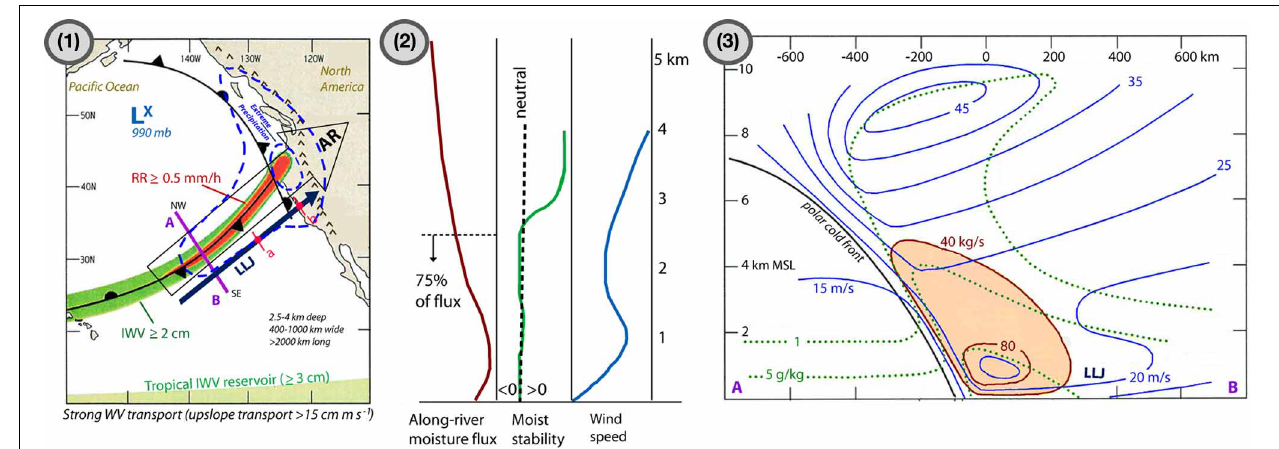
FIGURE 2 | Conceptual model scheme of an atmospheric river (AR) over the northeastern Pacific Ocean. (1) Plan-view schematic showing the relative positions of the polar-cold-front and the Low Level Jet (LLJ). The big arrow shows the AR and the blue one the LLJ. In dark green it is showed the concentrated integrated total column of water vapor (IWV) ≥ 2cm and in red the associated rain-rate enhancement (RR) ≥ 0.5mm/h along the AR. The broken blue line defines a symbolic area of precipitation associated to the full system. The magenta line A–B defines a cross-section projection for (3). The pink segments over the pre-cold-frontal LLJ (with a–b) marked the limits with profiles for (2) are integrated. At the bottom in light green it is showed the tropical IWV reservoir ( > 3cm). (Note